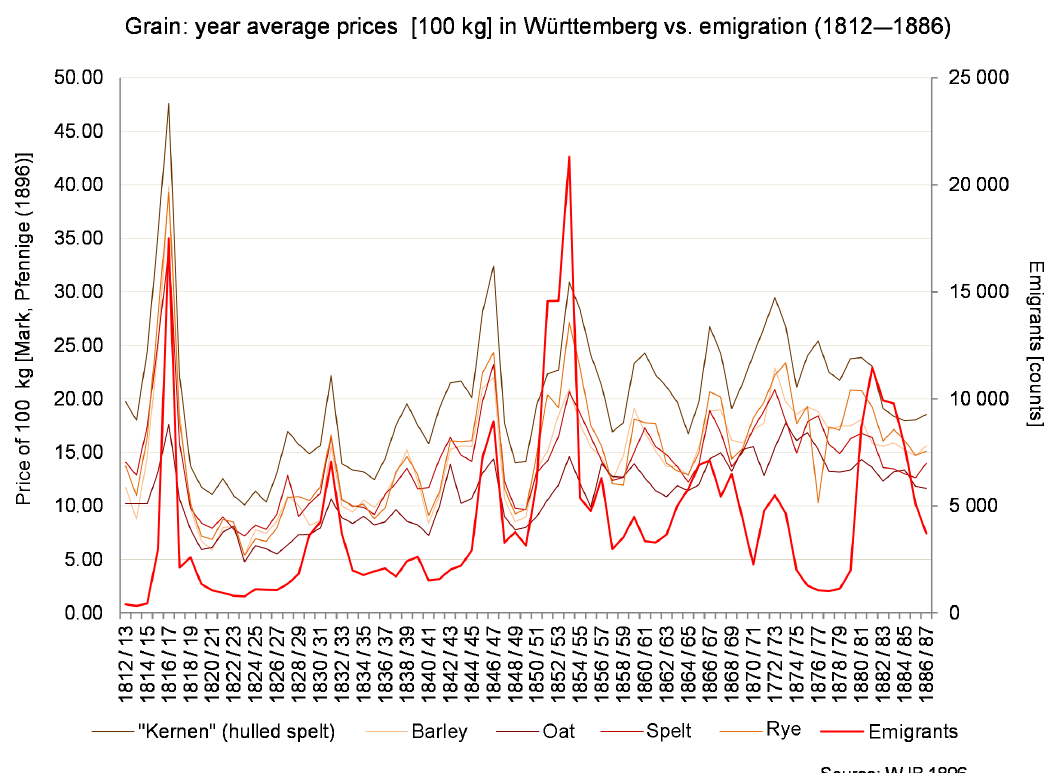
Figure 5. Comparison of grain prices and the number of emigrants in the kingdom of Württemberg